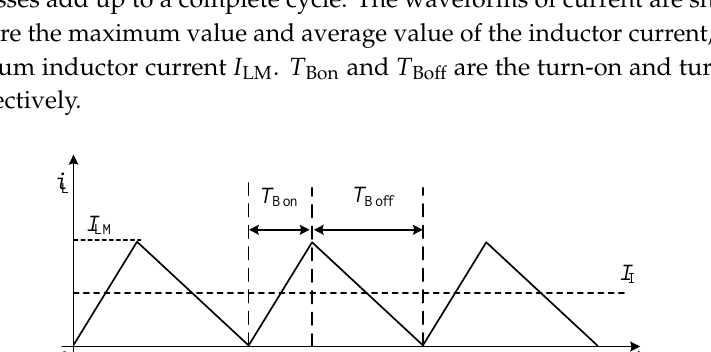
Figure 12. Setup of the experimental system.